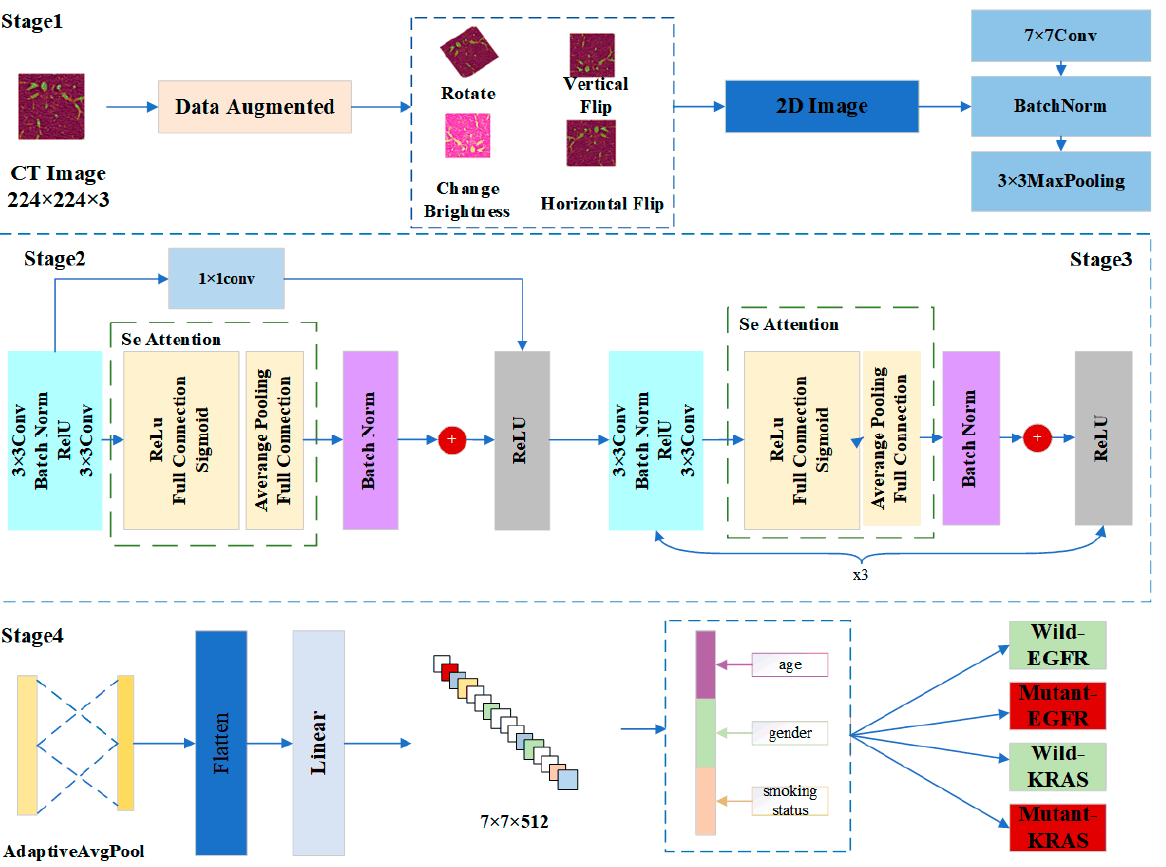
Figure 1. The framework of our proposed Mut-SeReSnet model.